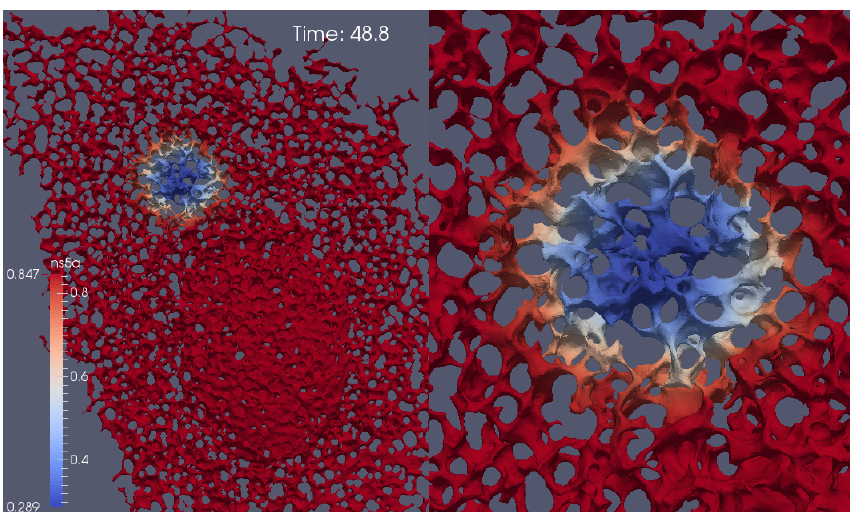
Figure 4. Simulation of NS5A concentration at the ER surface during a FRAP experiment, screenshot of supplemental movie “S1 Video in supplementary material”. The movie shows the simulation of the diffusion of NS5A on the ER surface, (8). At the beginning, the NS5A concentration is small within the (bleached) FRAP ROI F . During the simulation, the diffusion of NS5A enhances the FRAP ROI concentration again. (The complete equilibrium is not reached within the time which corresponds to the time of the FRAP experiments as within the experimental case [34]). Red indicates high NS5A concentration, blue low concentration. Right hand side: zoom of the zone around the FRAP ROI.